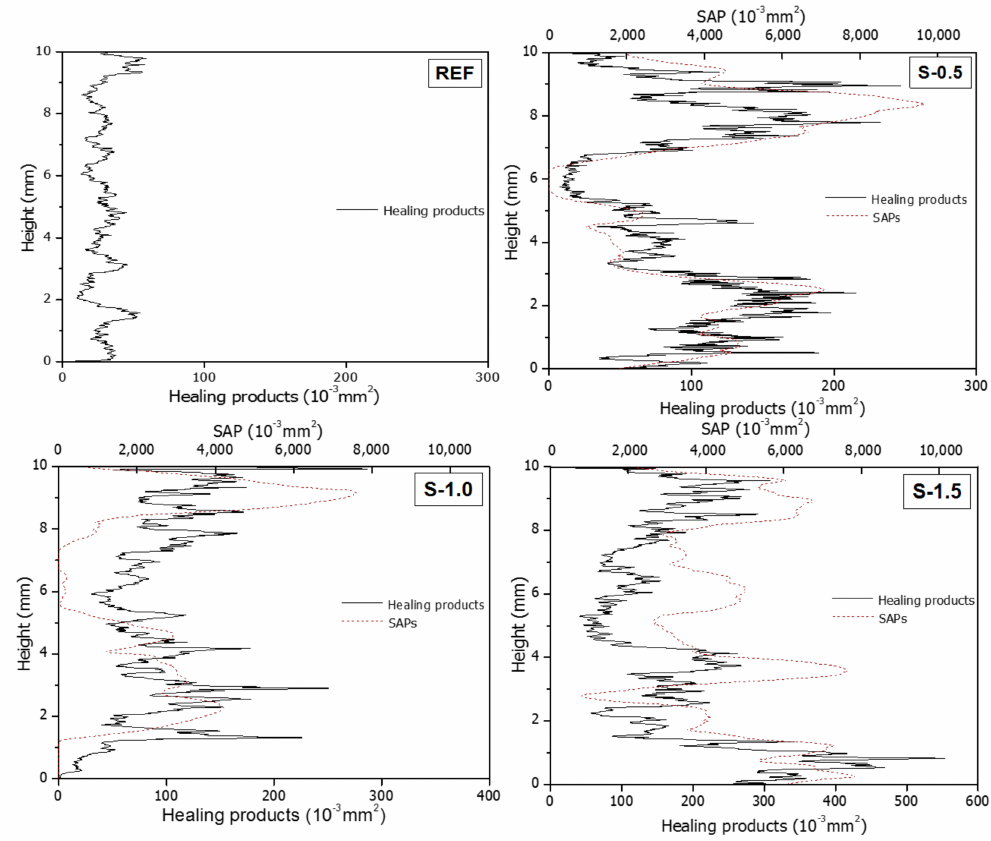
Figure 14. Areas of healing products and SAPs over the height of the